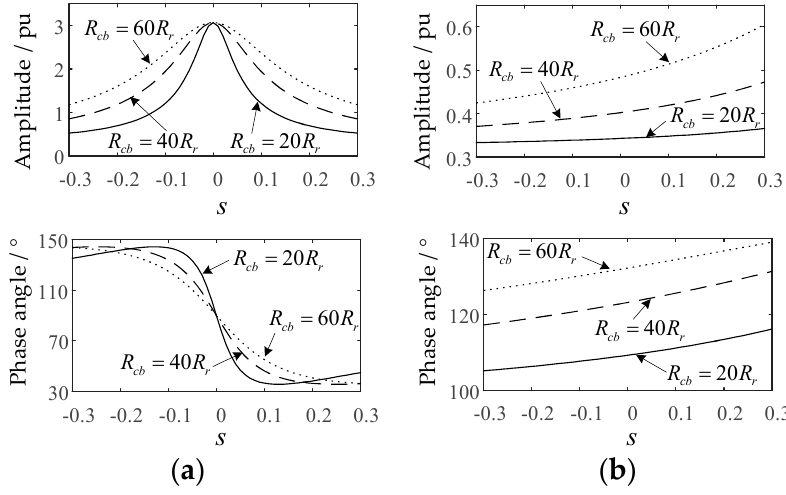
Figure 4. Amplitude and phase angle curves of: ( a ) Z a + ; and ( b ) Z b + .